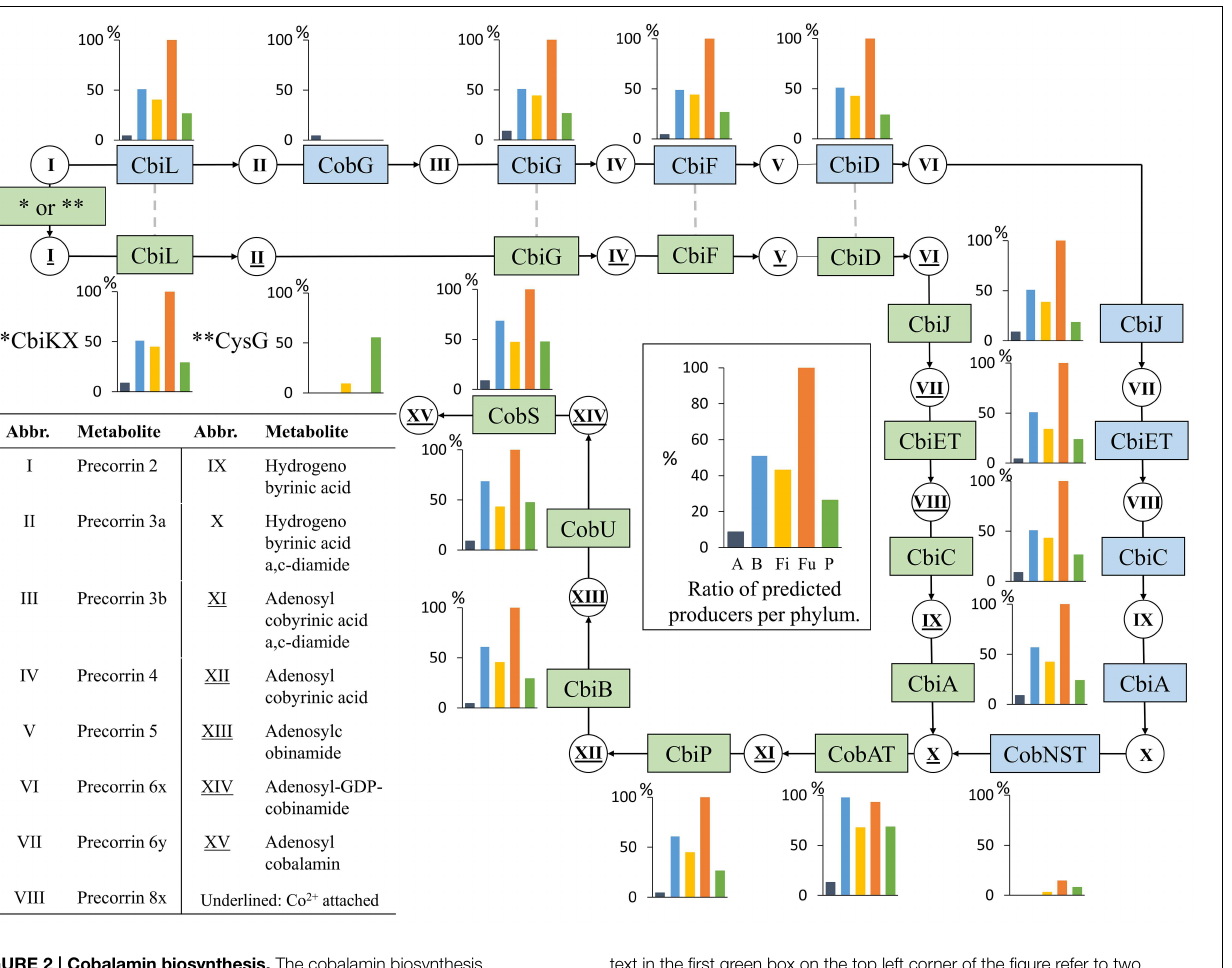
text in the first green box on the top left corner of the figure refer to two functional roles “ * CbiKX” and “ ** CysG”. The corresponding bar charts for the two functional roles are shown below the green box, just above the “Abbr./Metabolites” table.